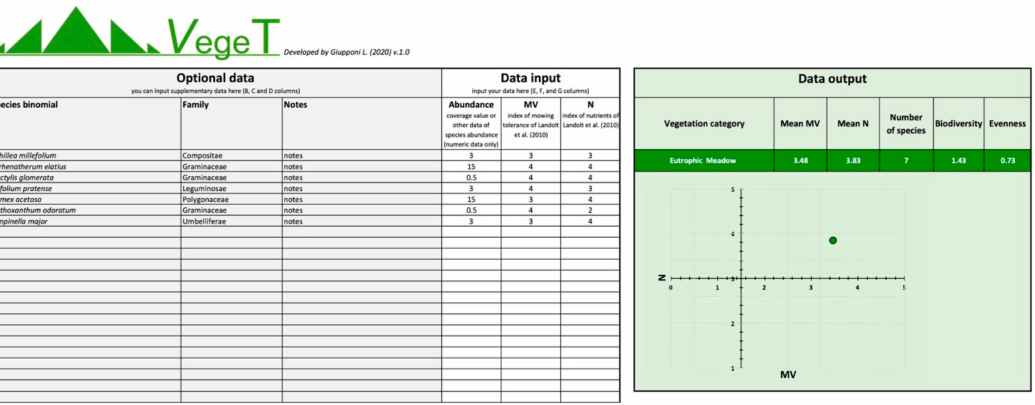
Figure 6. Input–output interface data of VegeT